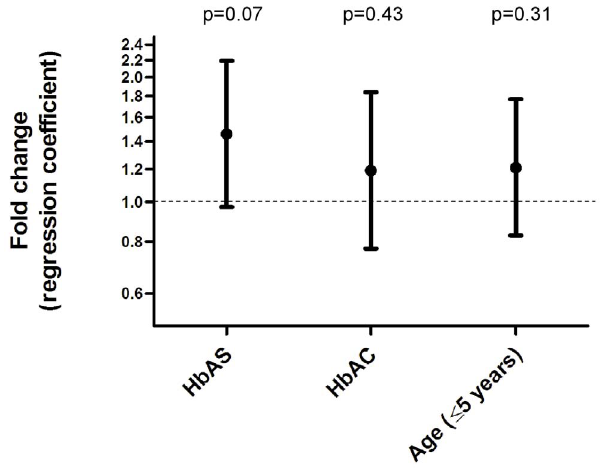
Figure 2. Relationship between cytoadherence, Hb type, and host age. A Poisson regression model was constructed to examine the effect of Hb type and host age on the cytoadherence of parasitized RBCs to MVECs. Fold-changes and 95% CIs of the relative binding compared to parasites from HbAA (for HbAS and HbAC) children and parasites from . 5-year-old (for # 5-year-old) children are